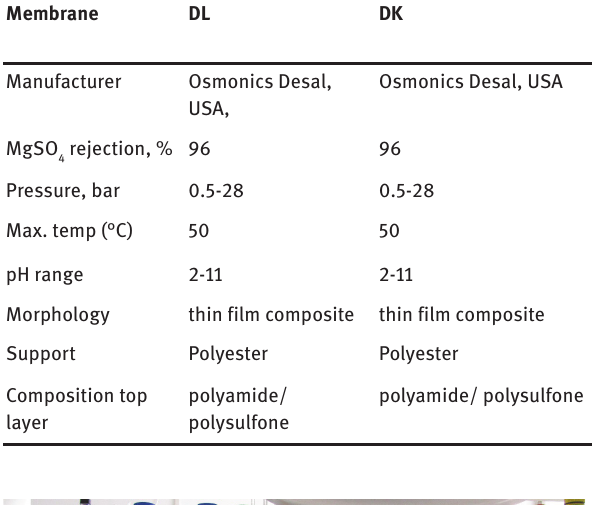
Table 2: Overview of the used NF membranes with manufacturer’s specification.